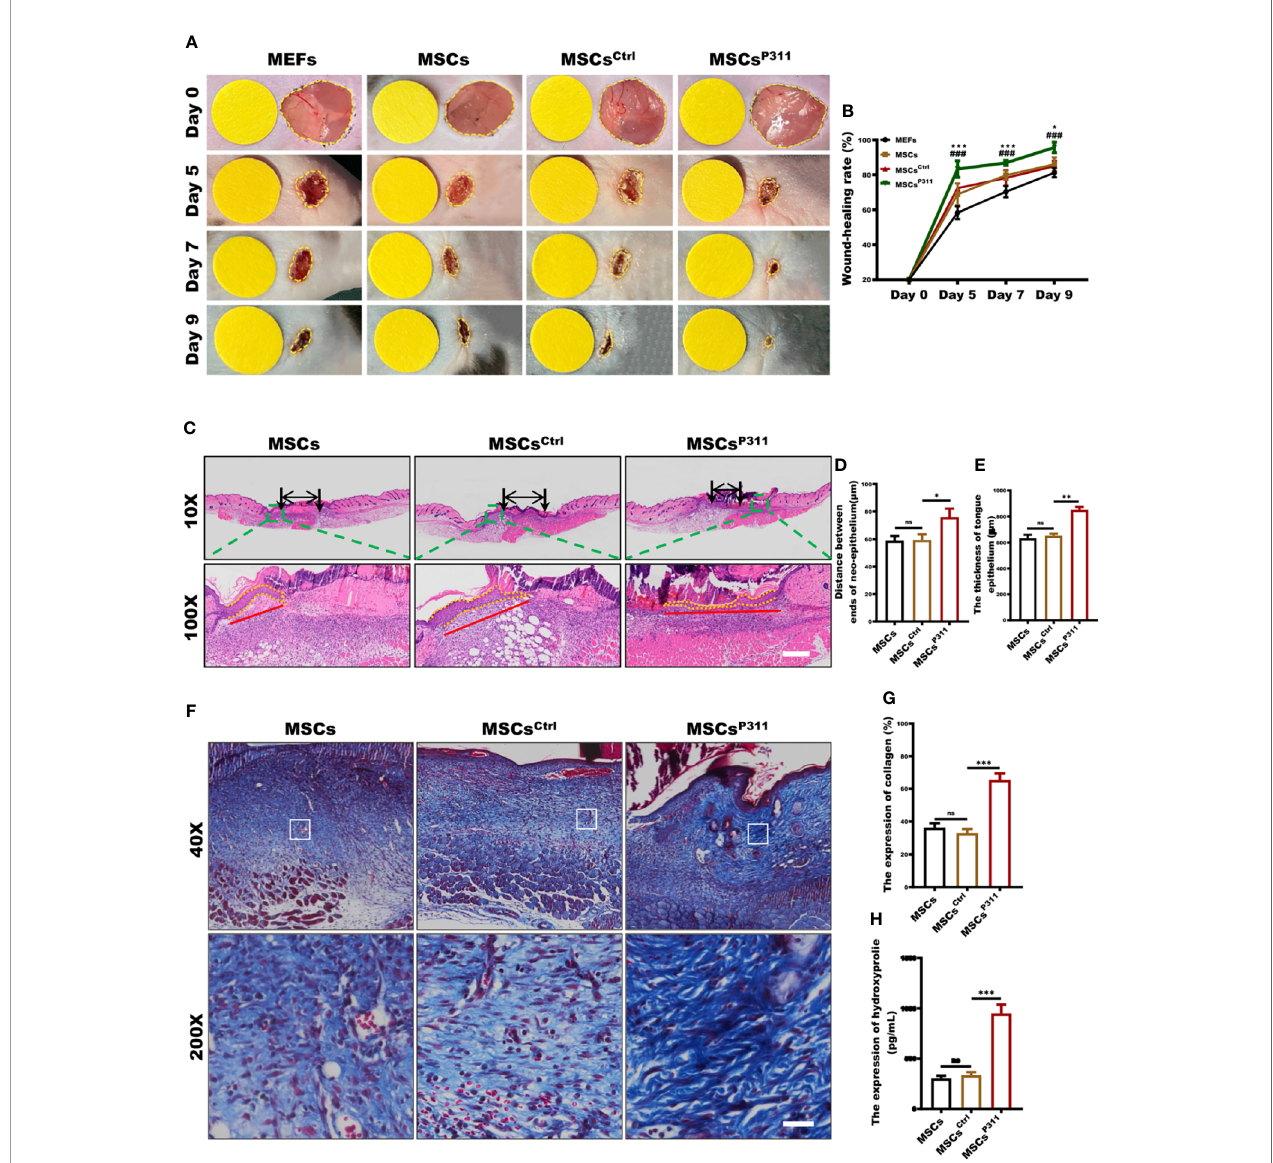
FIGURE 1 | P311 could enhance the capability of MSCs-mediated promotion of skin wound repair. Full-thickness wounds were created on both sides of the dorsal skin in sex- and age- matched C57BL/6 mice. Wound closure kinetics in mice subcutaneously injection with 1×10 6 MEFs, MSCs, MSCs Ctrl or MSCs P311 after wounding immediately (n=3/group) was analysed. (A, B) Representative photos of wounds on 5, 7 and 9 days post-wounding were shown (left panel). The open wound area was normalised to 1cm-diameter yellow circle which was the same size as the area of wound on day 0, and wound closure curve was statistically analysed (right panel). (* means MEFs vs MSCs) (C – E) The re-epithelialisation of wounds on day 7 post-excision was determined by H&E staining in mice with MSCs, MSCs Ctrl , or MSCs P311 administration (n=3/group). Representative H&E images of re-epithelialisation were shown, and the distance between ends of neo-epithelium (black arrows), the length (red solid line) and thickness (yellow dotted line) of neo-epithelial tongue were statistically analysed, respectively. Scale bar: 200 µm. (F, G) Representative Masson images of granulation tissue were shown, and the expression of total collagen with blue staining was statistically analysed. Scale bar: 50 µm. (H) The contents of HYP were examined and analysed in wound tissues. Data are representative of at least three independent experiments and represent mean ± SD of indicated number of mice per group. (ns, no statistical signi fi cance; *P < 0.05, **P < 0.01; *** ,### P <